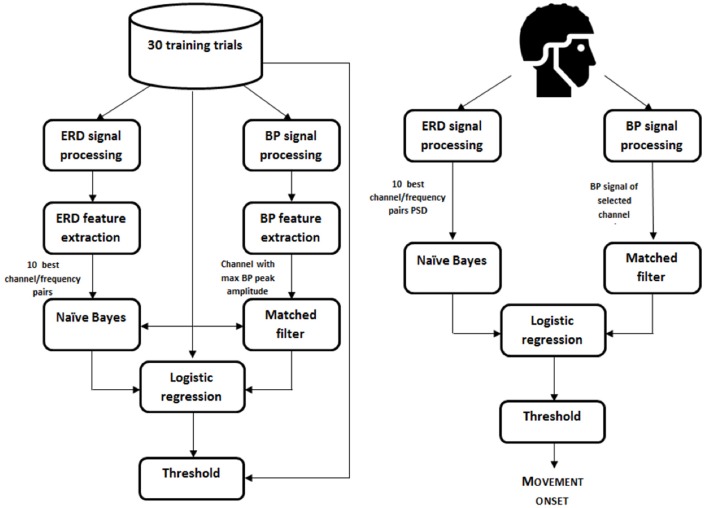
Movement onset decoder scheme. Left, calibration; Right, online decoding.